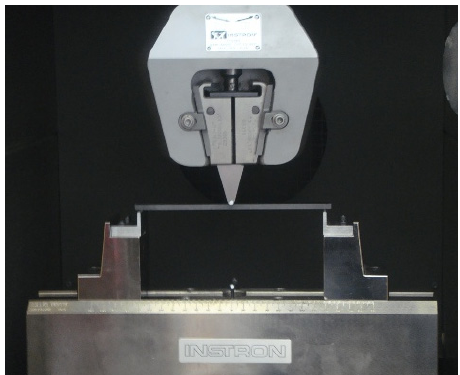
Figure 5: Bending test of unidirectional fiberglass (Direct "E" roving 0.7 - orthophthalic polyester resin